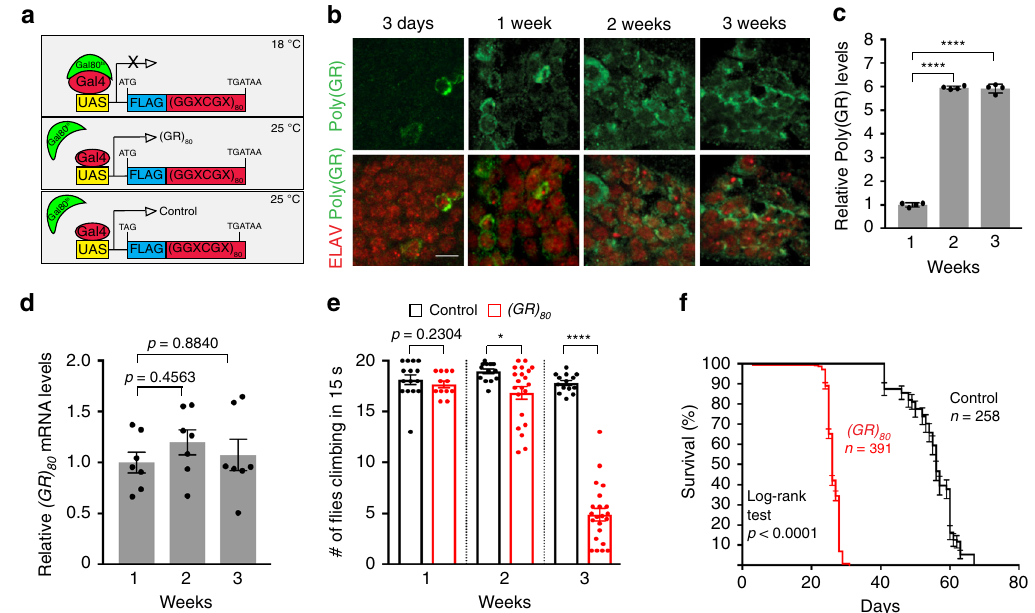
Fig. 1 Establishment of a Drosophila model of C9ORF72 - ALS/FTD. a Schematic of the fl y model in which Gal80 ts inhibits Gal4-mediated transcription of (GR) 80 at 18 °C, thus poly(GR) is expressed in a spatially and temporally controlled manner. (GR) 80 is encoded by (GGXGCX) 80, where X is any one of the four nucleotides. b Immunostaining of poly(GR) in ELAV-positive neurons of fl ies aged 3 days to 3 weeks old. Scale bar: 5 μ m. c Meso Scale Discovery (MSD) ELISA analysis of poly(GR) levels in lysates of heads from 1 to 3-week-old fl ies. Each data point is from an independent cross, n = 4 independent crosses. Values are mean ± s.e.m. **** p < 0.0001 (one-way ANOVA, Dunnett ’ s test). d qPCR analysis of the (GR) 80 mRNA level in the brain of 1 – 3-week- old fl ies with pan-neuronal expression of (GR) 80 . n = 7 independent genetic crosses and mRNA measurements. Values are mean ± s.e.m. (one-way ANOVA, Dunnett ’ s test). e Control and (GR) 80 fl ies at the indicated ages (one dot = 20 fl ies) were analyzed with the negative geotaxis climbing assay. n = 15, 12, 14, 21, 14, and 22 assays for control and ( GR ) fl ies at 1, 2, and 3 weeks, respectively. Values are mean ± s.e.m. * p < 0.05; **** p < 0.0001 80 (Mann – Whitney test). f Survival analysis of control and (GR) 80 fl ies grown at 25 °C. Source data are provided as a Source Data fi